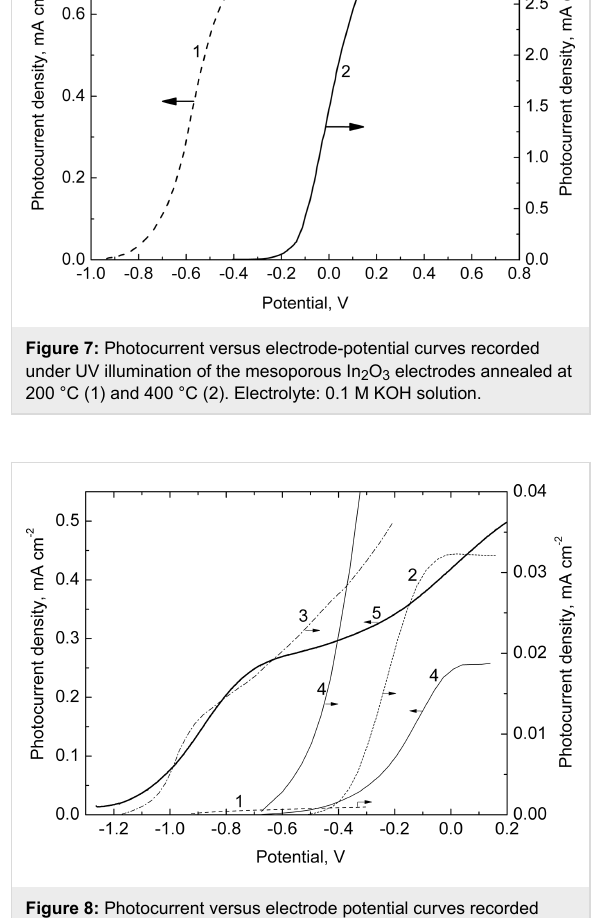
Figure 8: Photocurrent versus electrode potential curves recorded under visible-light illumination of the In 2 O 3 (1, 2) and In 2 O 3 /CdS elec- trodes (3–5). The In 2 O 3 films were annealed at 200 (1, 3) and 400 °C (2, 4, 5). The number of the SILAR cycles of CdS deposition was 10 (3, 4) and 50 (without the step of intermediate rinsing with distilled water, 5). Electrolyte: 0.1 М Na 2 S + 0.1 M Na 2 SO 3 + 0.1 M NaOH